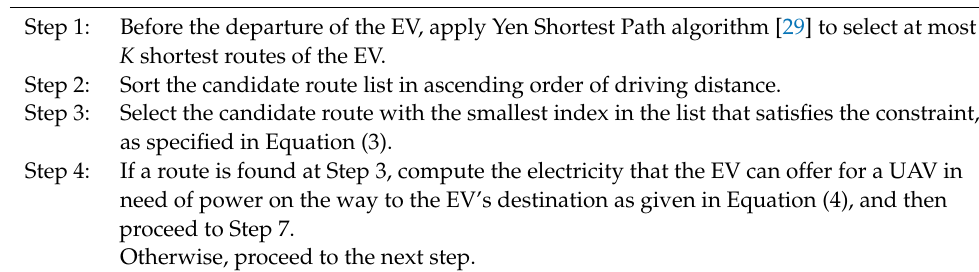
Algorithm 1 Route and Charging and Discharging Planning for an